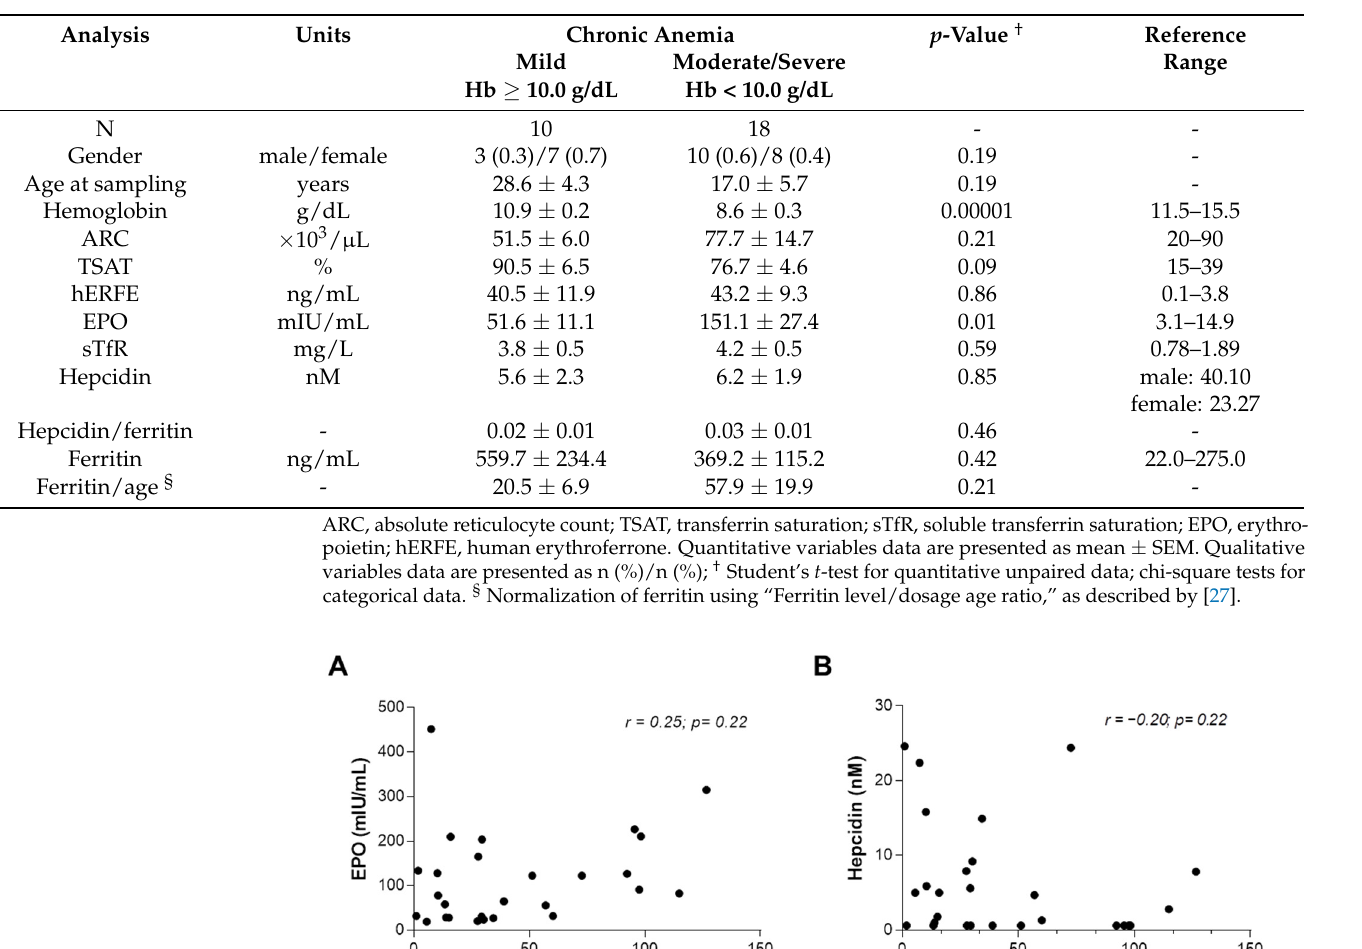
Table 1. CDA II patients enrolled in the study.